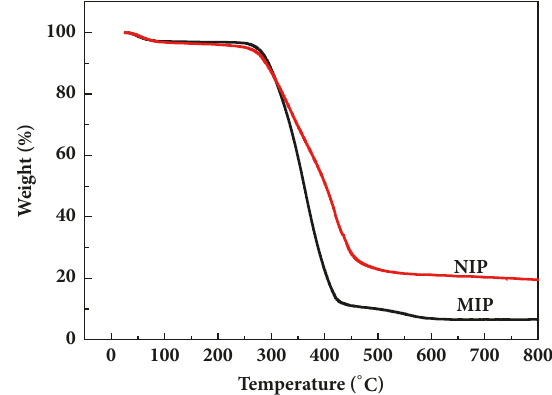
Figure 2: Thermogravimetric curves of P printed polymers